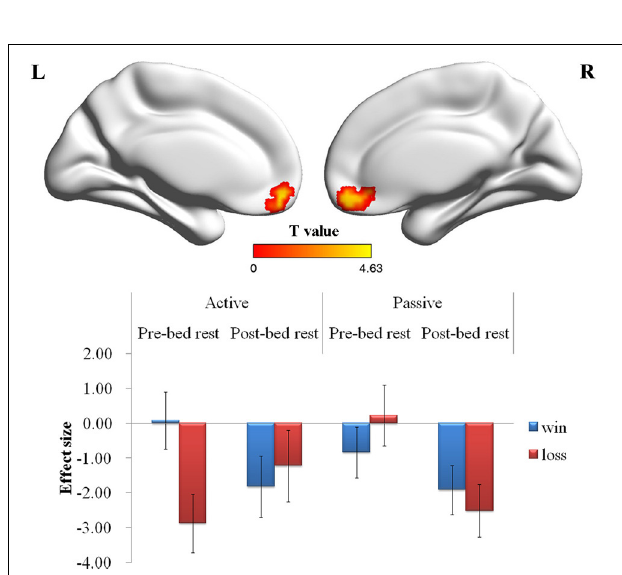
FIGURE 4 | Outcome-related brain regions showing the Three-Way interaction. Before bed rest, the activation of VMPFC in the active choice condition was greater in the win outcome than in the loss outcome, whereas it showed no significant difference between the win and loss outcomes after bed rest. In contrast, the activation of VMPFC in the passive choice condition did not differ between win and loss outcomes, either before bed rest or after bed rest. Abbreviations: VMPFC, ventromedial prefrontal cortex. Error bar denotes the standard error.